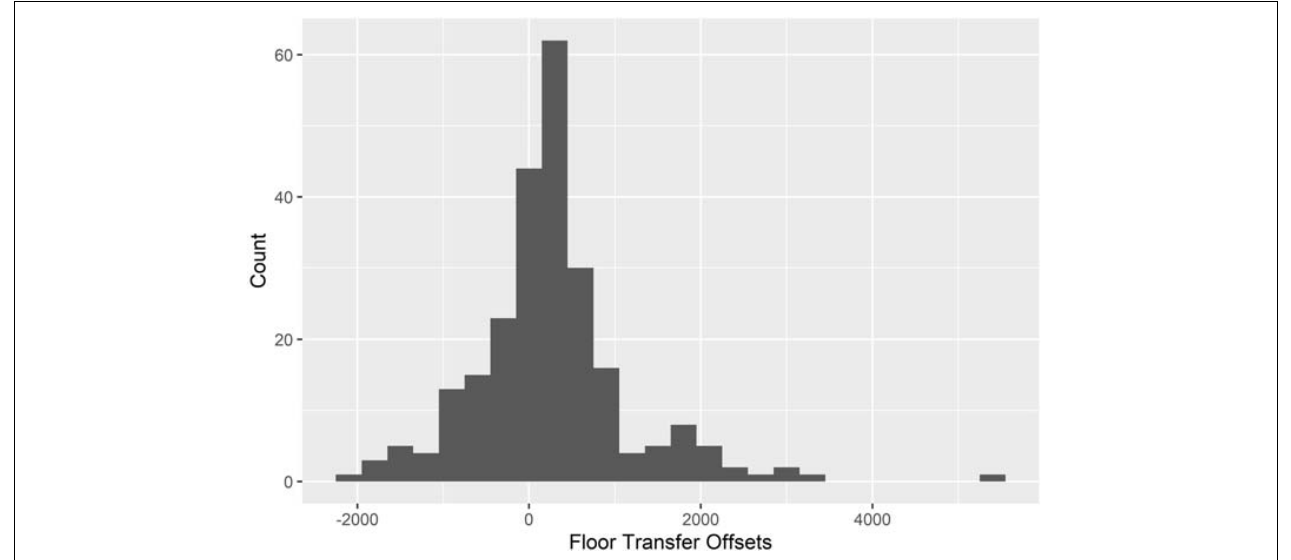
FIGURE 2 | A histogram depicting the floor transfer offsets (i.e., the inter-utterance gaps for gap utterances and between-overlaps) in the final dataset.